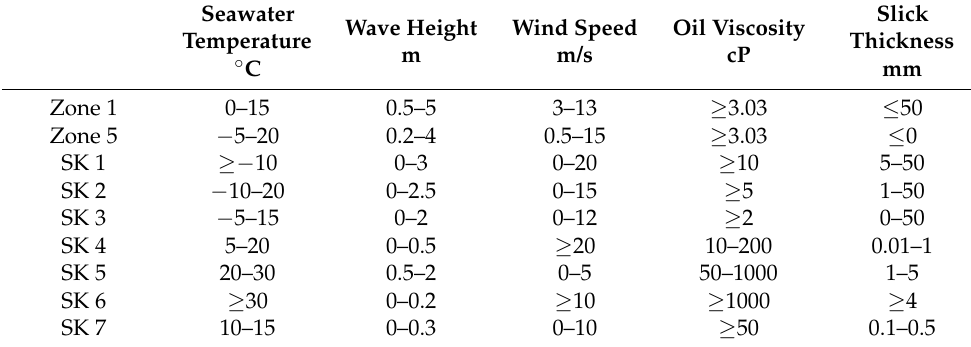
Table 2. Information of site conditions and skimmer